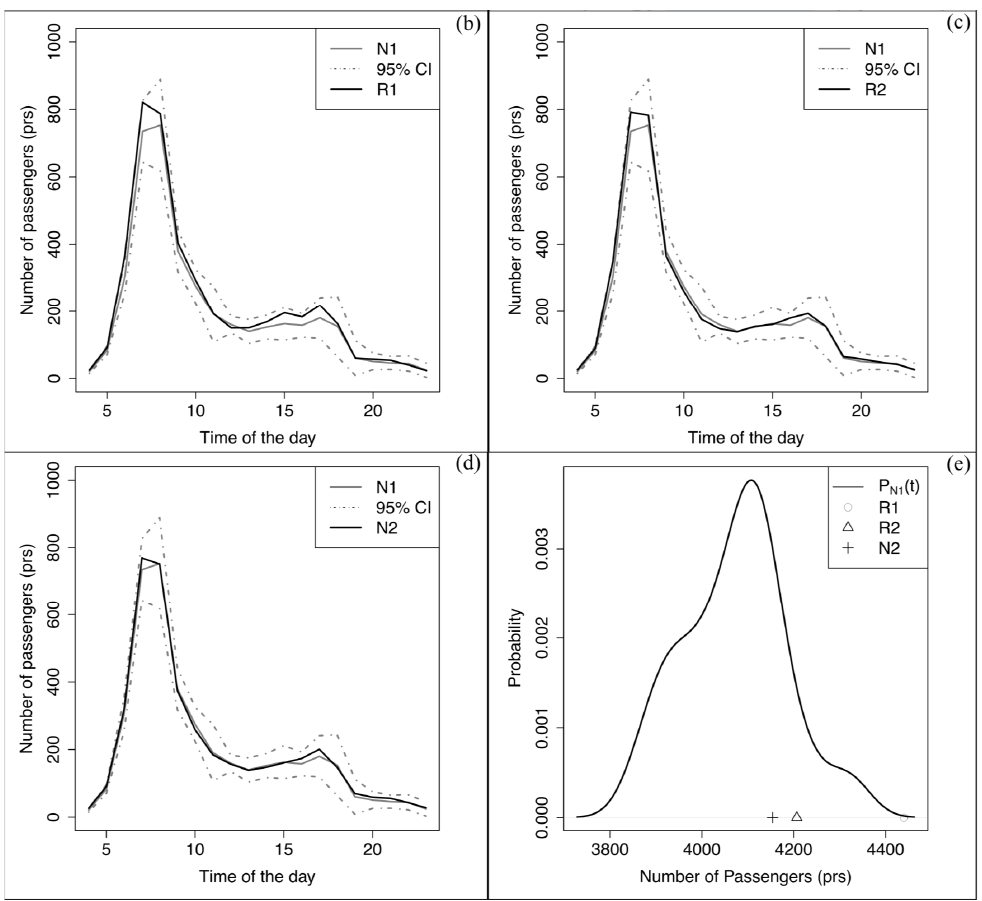
Figure 2. ( a ) Map of Bay Area Rapid Transit (BART) stations; ( b ) comparison of the average weekday hourly ridership between N1 and R1 at El Cerrito Plaza station; ( c ) comparison of the average weekday hourly ridership between N1 and R2 at El Cerrito Plaza station; ( d ) comparison of the average weekday hourly ridership between N1 and N2 at El Cerrito Plaza station; and ( e ) empirical probability distribution of the daily demand observed at El Cerrito Plaza station prior to the Maze Meltdown.